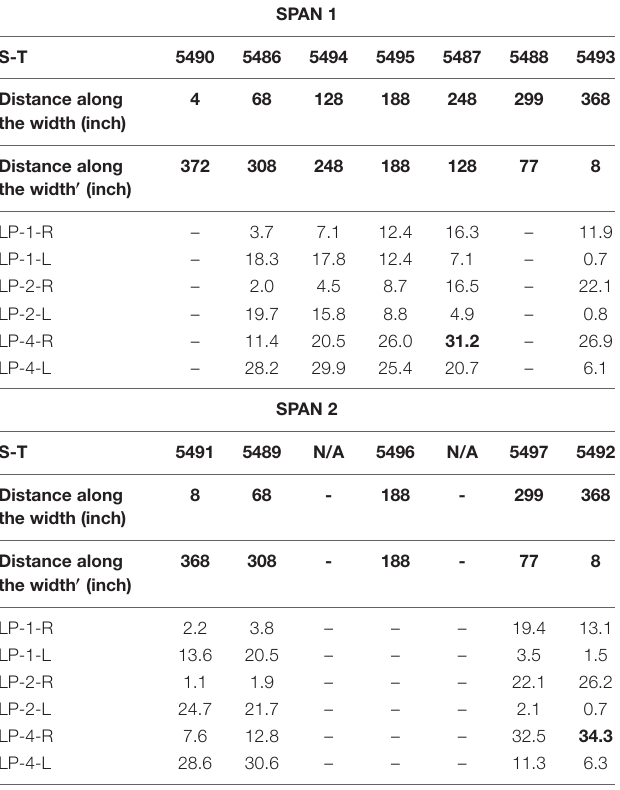
TABLE 3 | Summary of strains for each static load pattern ( µε ) – span 1 and 2.